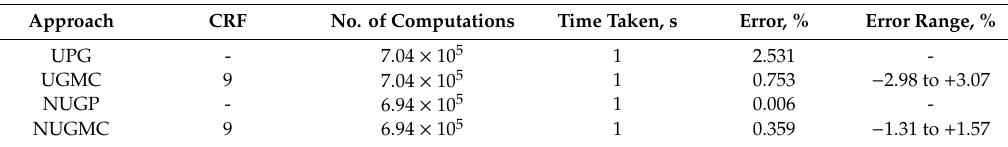
Table 8. Computation of view factor using all routines. Example with perpendicular, whole surfaces, case in Figure 4c, with non-uniform reflecting horizontal surface.